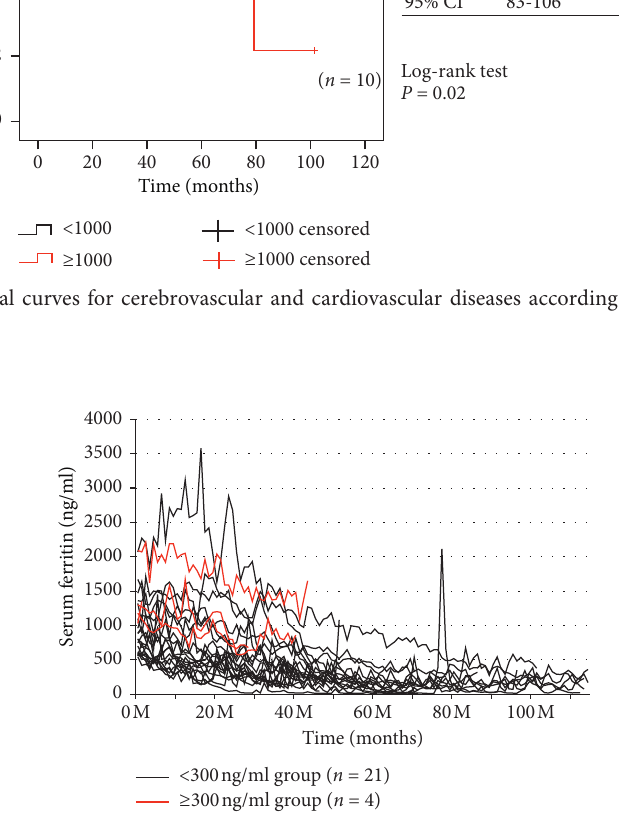
Figure 4: Changes in serum ferritin levels over 10years of follow-up in patients with serum ferritin levels > 500ng/mL at baseline. Red lines: the serum ferritin levels did not decrease to < 300ng/mL during the 10-year follow-up